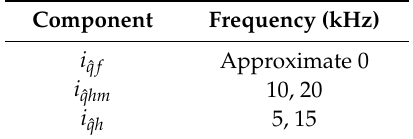
Table 1. Distribution of the components of i ˆ q